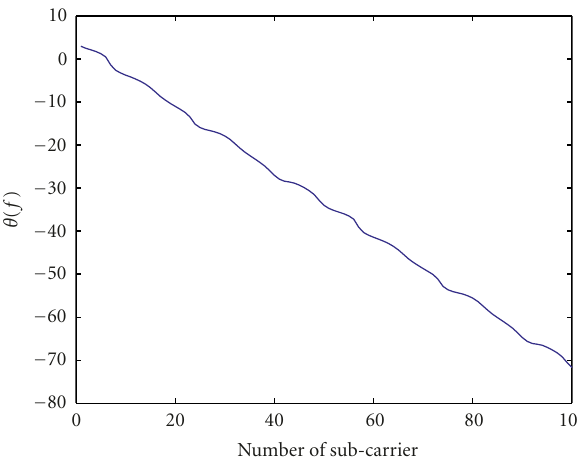
Figure 6: Phase variation of multipath fading channel in a typical urban environment with respect to OFDM spectrum.